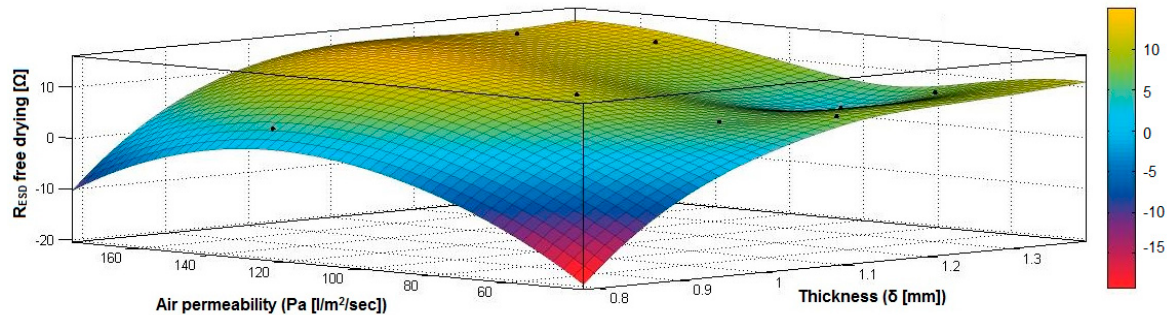
Figure 21. 3D representation R ESD free drying = f(Pa, δ ) samples preliminarily treated in RF plasma O 2 using RF 1 generator and power 200 W.